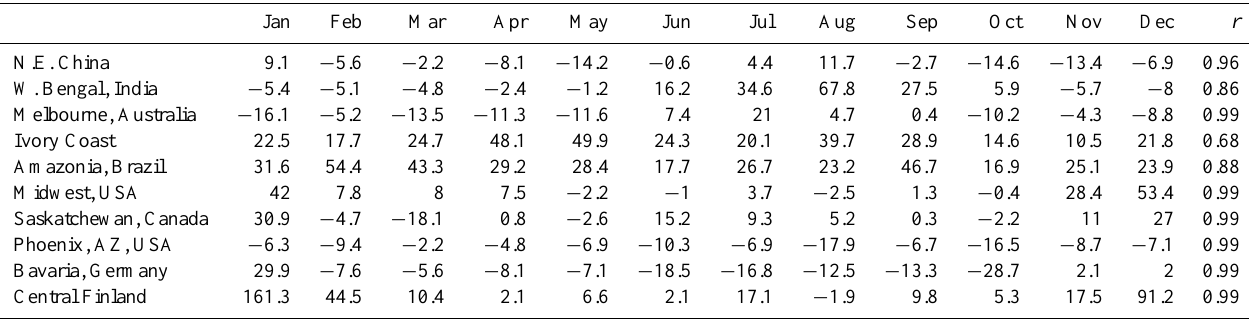
Table 3. The “all-sky” monthly mean shortwave radiative forcing (RF) of the Simple model relative to DISORT (shown as % deviation from DISORT) after a simulated − 0.1 surface albedo change. Correlation coefficients ( r) are also presented.